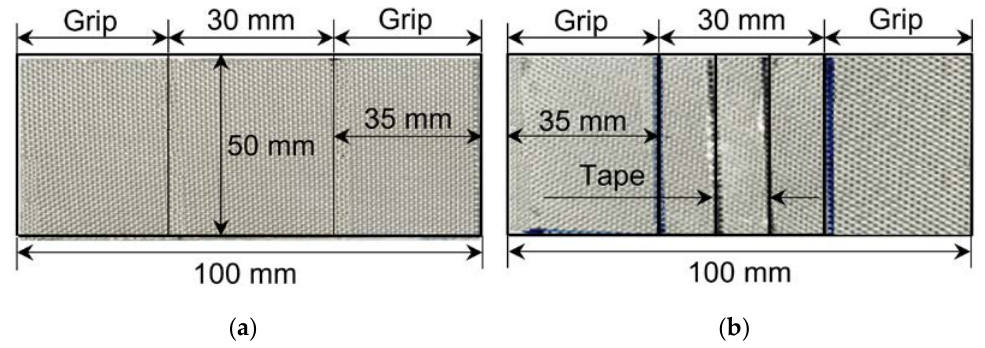
Figure 6. Shapes and dimensions of the mechanical test specimens: ( a ) without an adhesive filling vacancy and ( b ) with an adhesive filling vacancy.